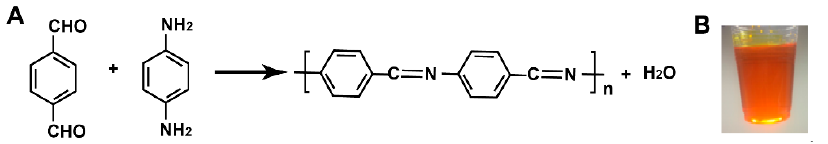
Figure 1. ( A ) The condensation reaction and ( B ) a picture of the as-prepared PAM in methanol solution.